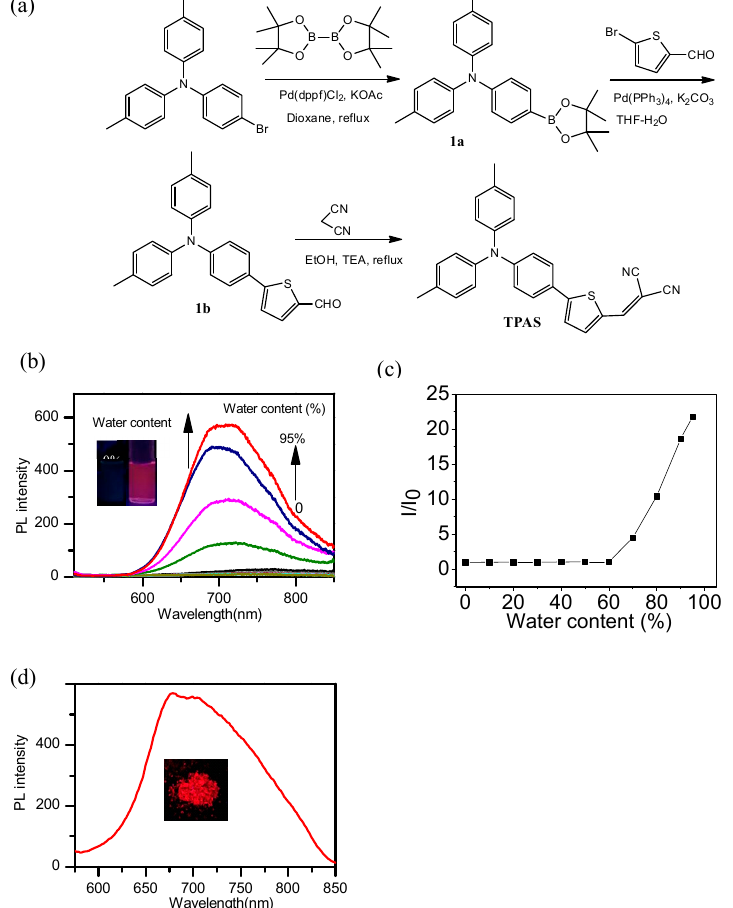
Figure 1. ( a ) Synthetic routes of target dye TPAS. ( b ) The emission spectra of TPAS (10 µ M) in CH 3 CN/water mixtures with different fraction of water ( λ em = 494 nm). ( c ) The fluorescence intensity ratio in presence of different fraction of water. ( d ) TPAS in solid state. Inset: photographs of TPAS in solid state under 365 nm UV